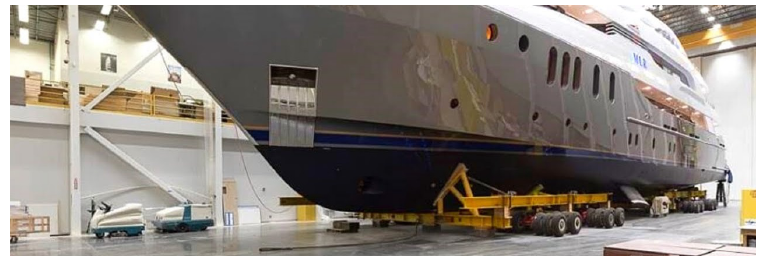
Figure 3. Conventional bow example with spray